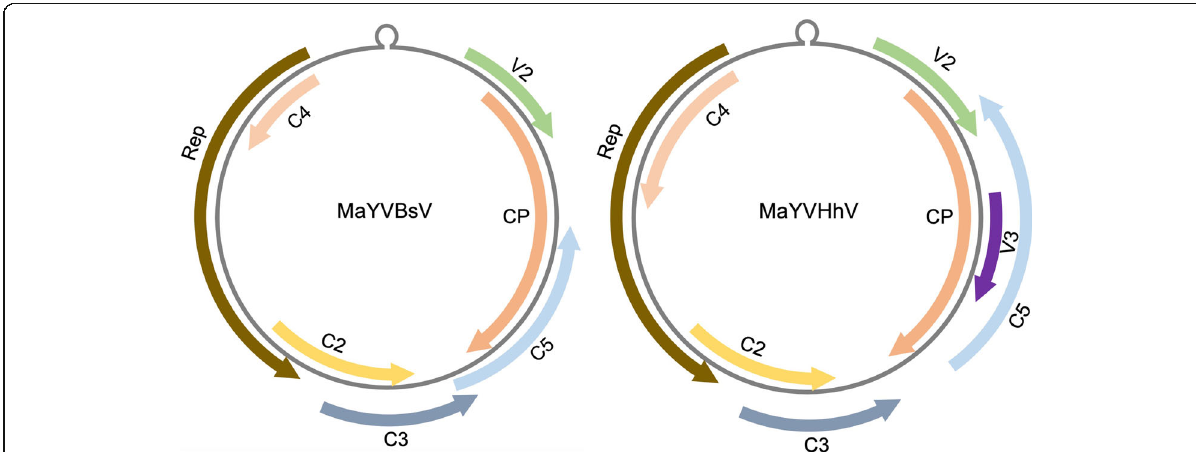
Fig. 1 Schematic representations of the genome organization of MaYVBsV and MaYVHhV. Different open reading frames (ORFs) with their respective products are